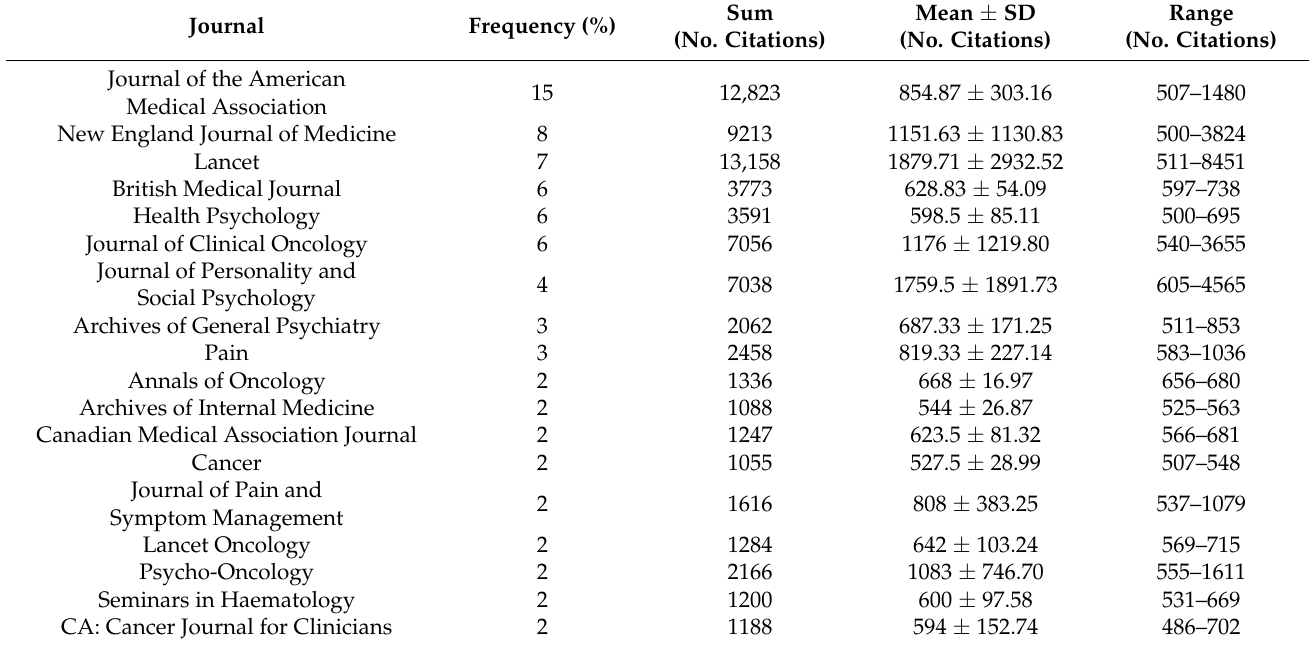
Table 2. Journals that have published the highest-cited articles as listed in